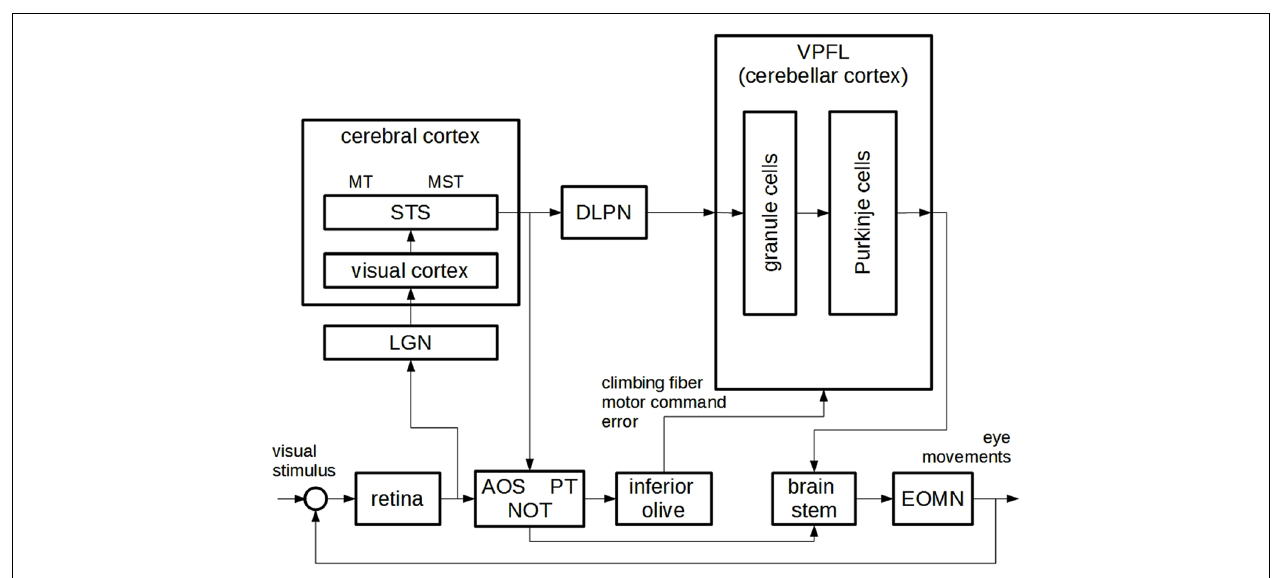
FIGURE 3 |A neuroscientific mechanism description for ocular-following reflex behavior, adapted from (Wolpert etal., 1998). AOS: accessory optic system; PT: pretectum; NOT: nucleus of optic tract; EOMN: extra-ocular